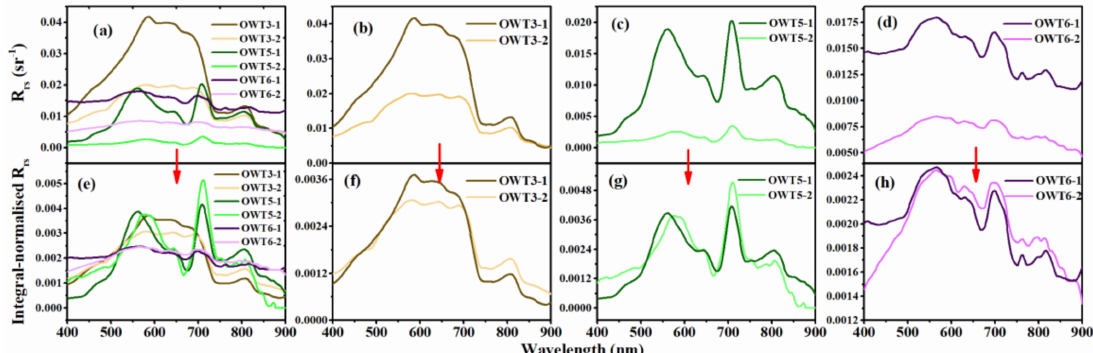
Figure 11. Six original spectra and their corresponding normalized R rs spectra from OWT3, OWT5, and OWT6. The original and normalized pairs are ( a – e ), ( b – f ), ( c – g ), and ( d – h ),